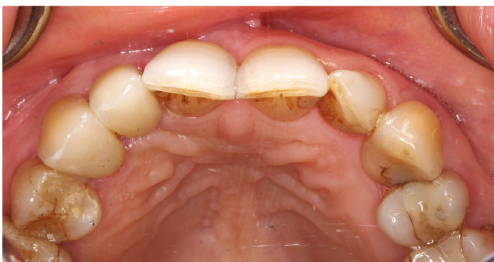
Figure 17: Implant prosthetic result after augmentation with 3D BB, implantation of a BLT implant with CARES abutment, and ceramic crown (top supervision).